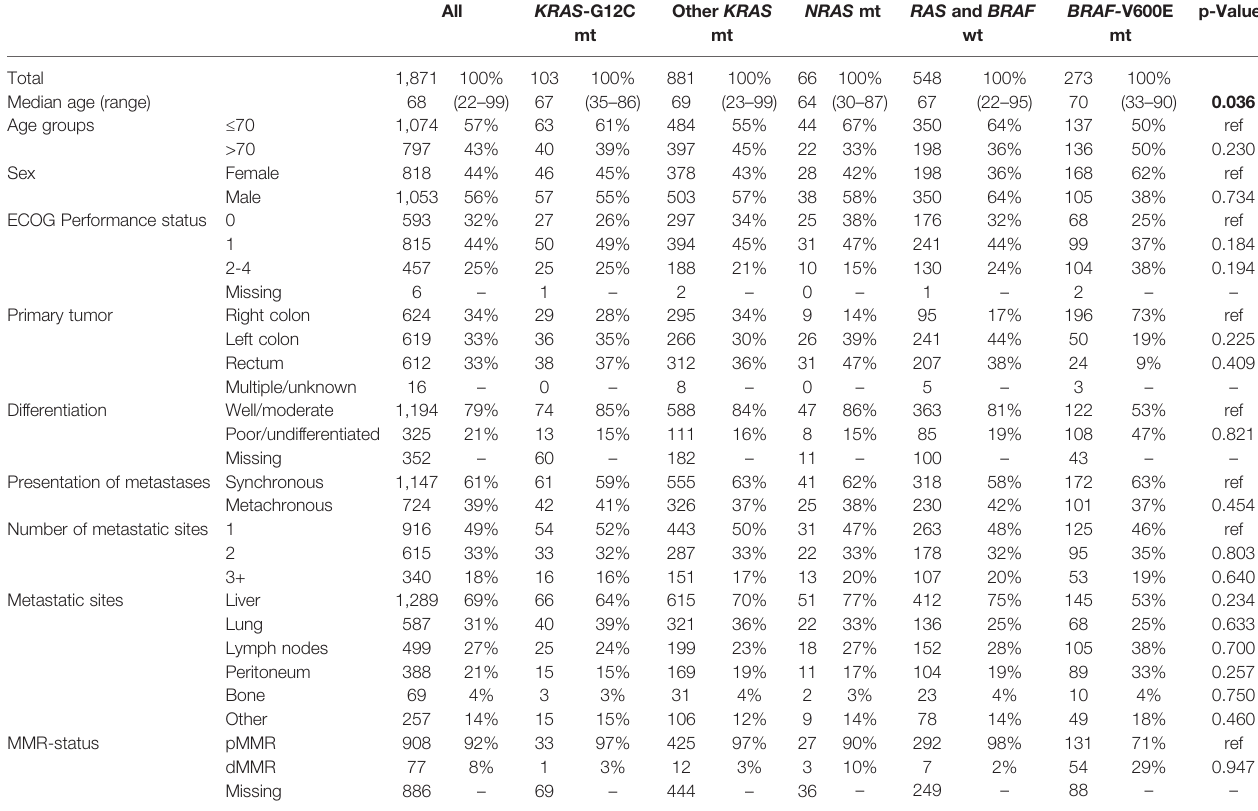
TABLE 1 | Demographics according to the type of